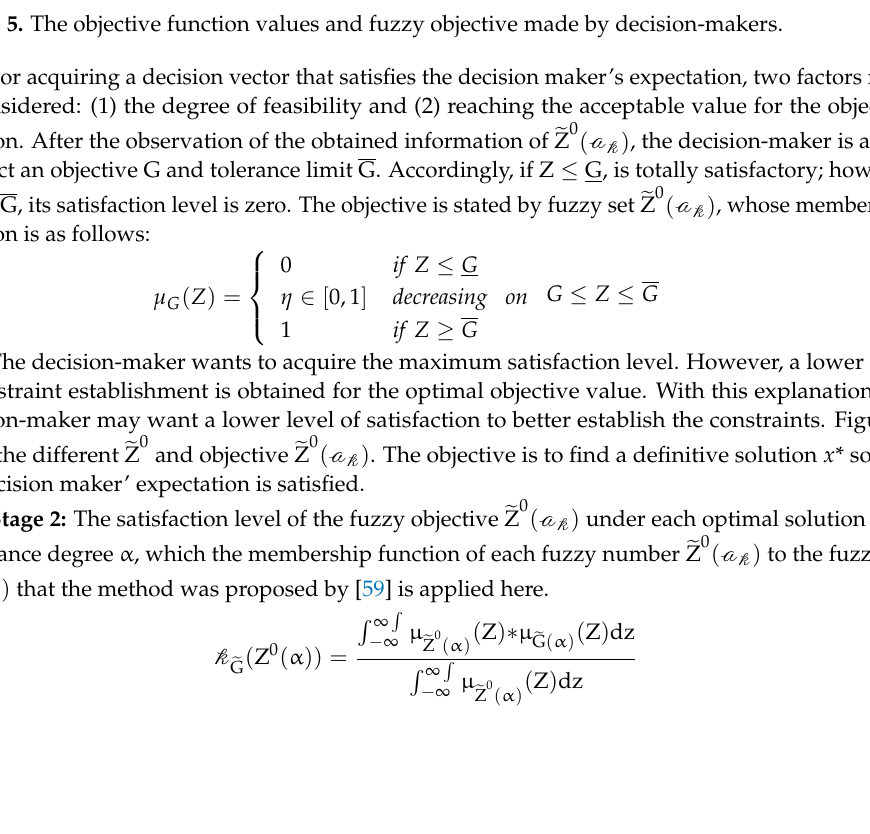
Figure 5. The objective function values and fuzzy objective made by decision-makers.